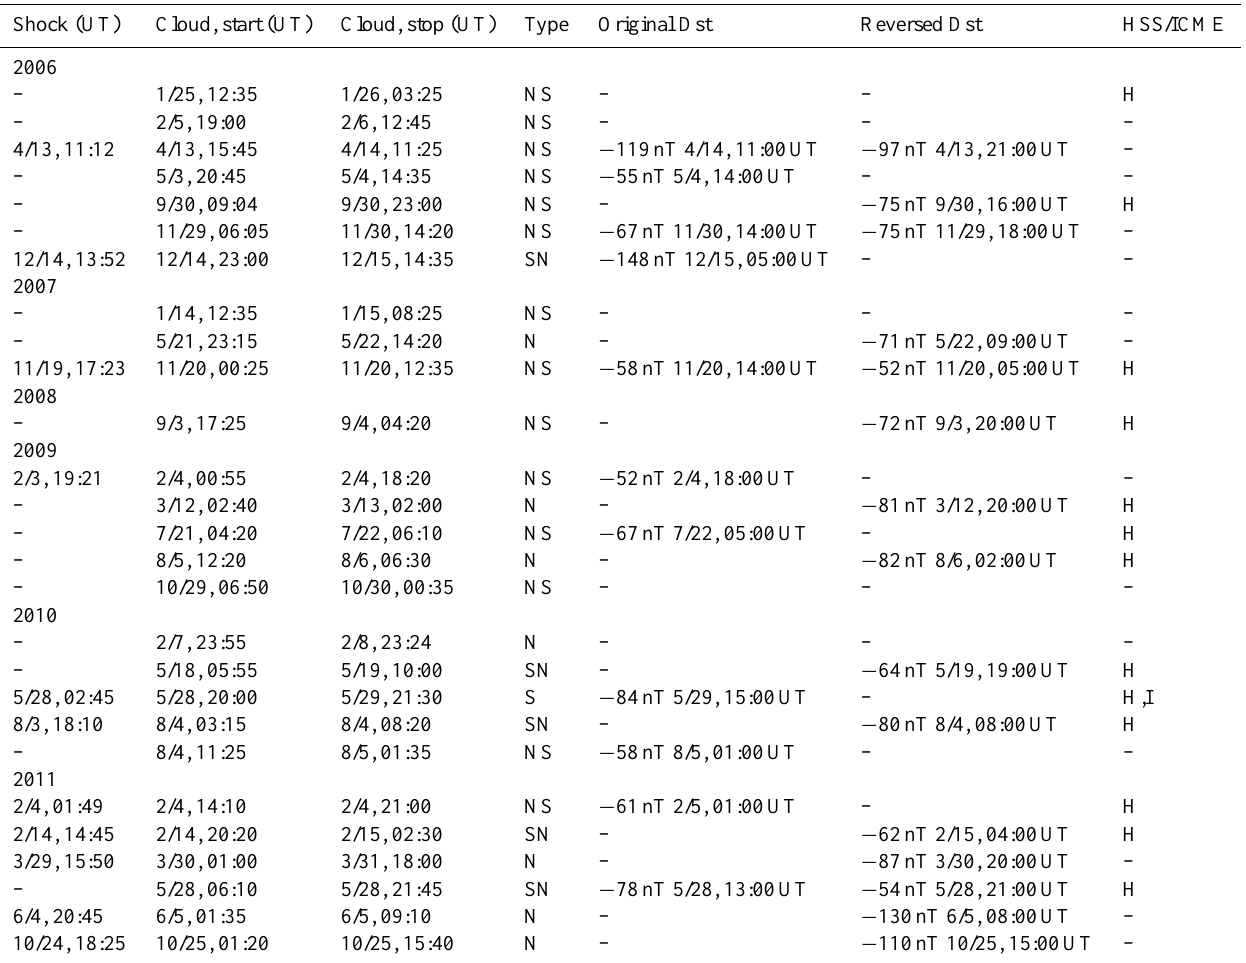
Table 2. Magnetic clouds during 2006–2011 (Period 2). The columns are the same as in Table 1. Shock (UT) Cloud, start (UT) Cloud, stop (UT) Type Original Dst Reversed Dst HSS/ICME